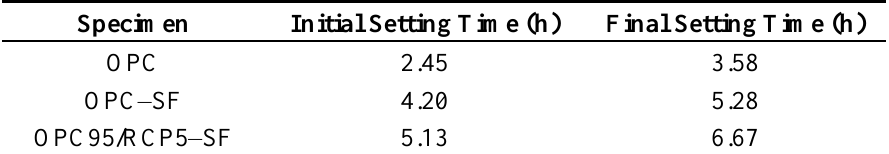
Table 7. Initial and final setting time of different